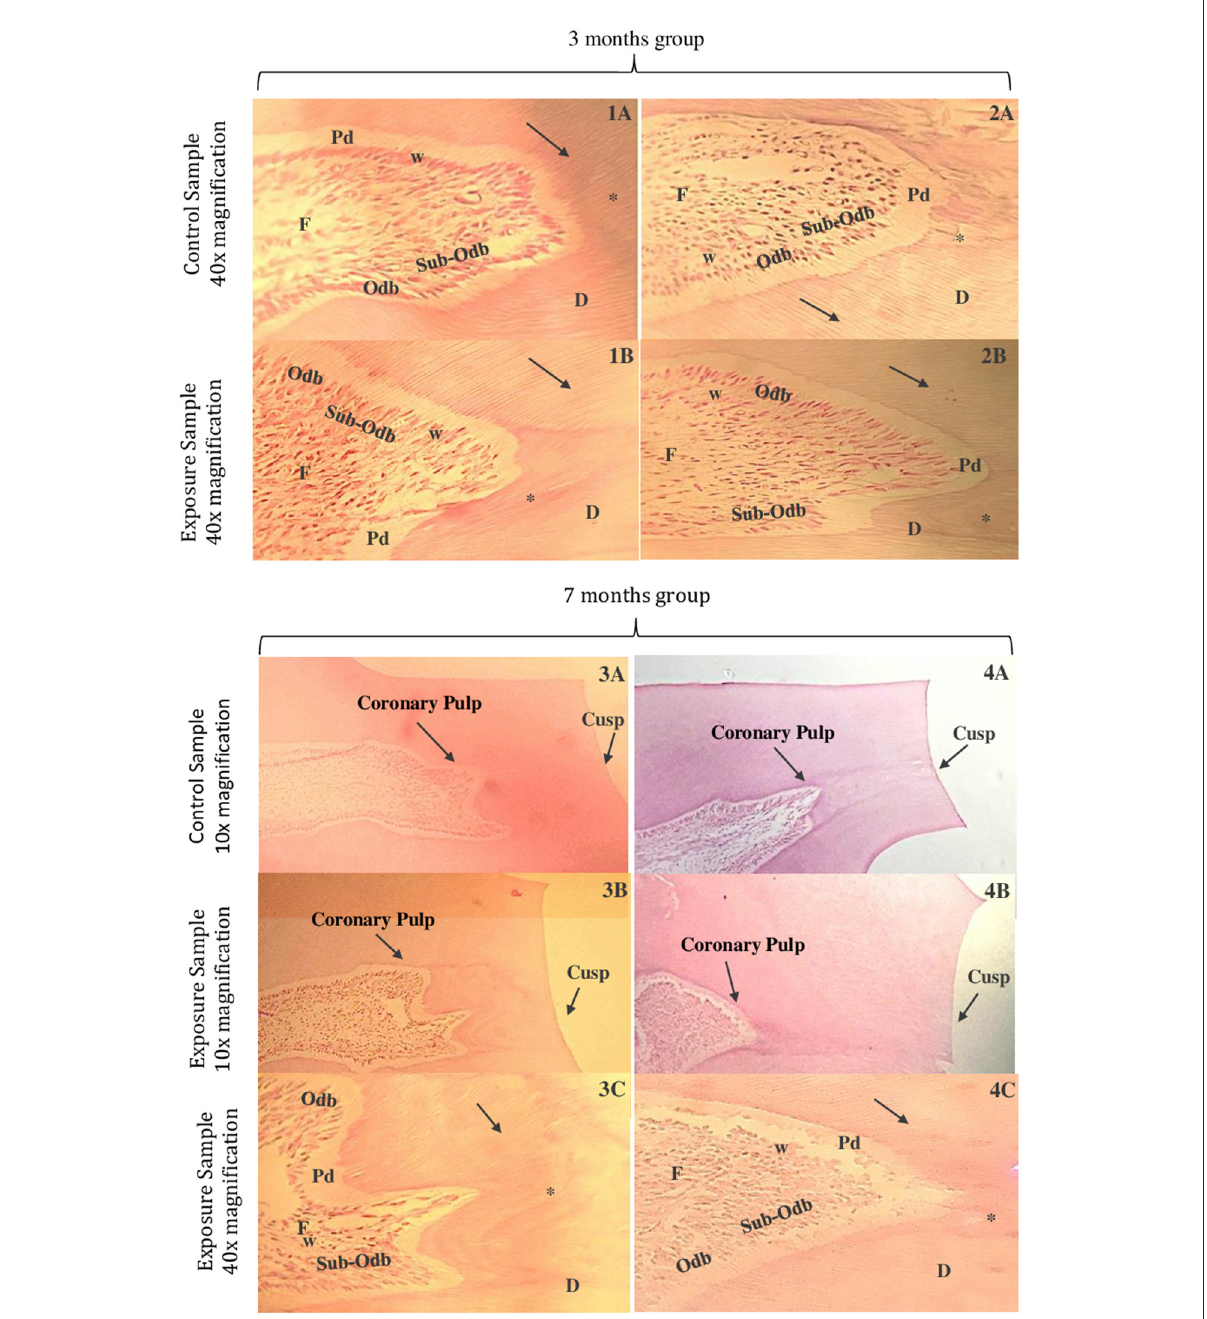
FIGURE3 Microphotographs of cross-sections of Wistar rat teeth. Third month control group samples at 40x magnification (1A,2A) . Third month exposed group samples at 40x magnification (1B,2B) . Seventh month control group samples at 10x magnification (3A,4A) . Seventh month exposed group samples at 10x magnification (3B,4B) . Seventh month exposed group samples at 40x magnification (3C,4C) . Dentin (D), pre-dentin (Pd), dentin tubules (arrow), odontoblastic layer (Odb), subodontoblastic layer (Sub-Odb), Weil zone (w), fibroblasts (F), and tertiary dentin incremental lines (*)